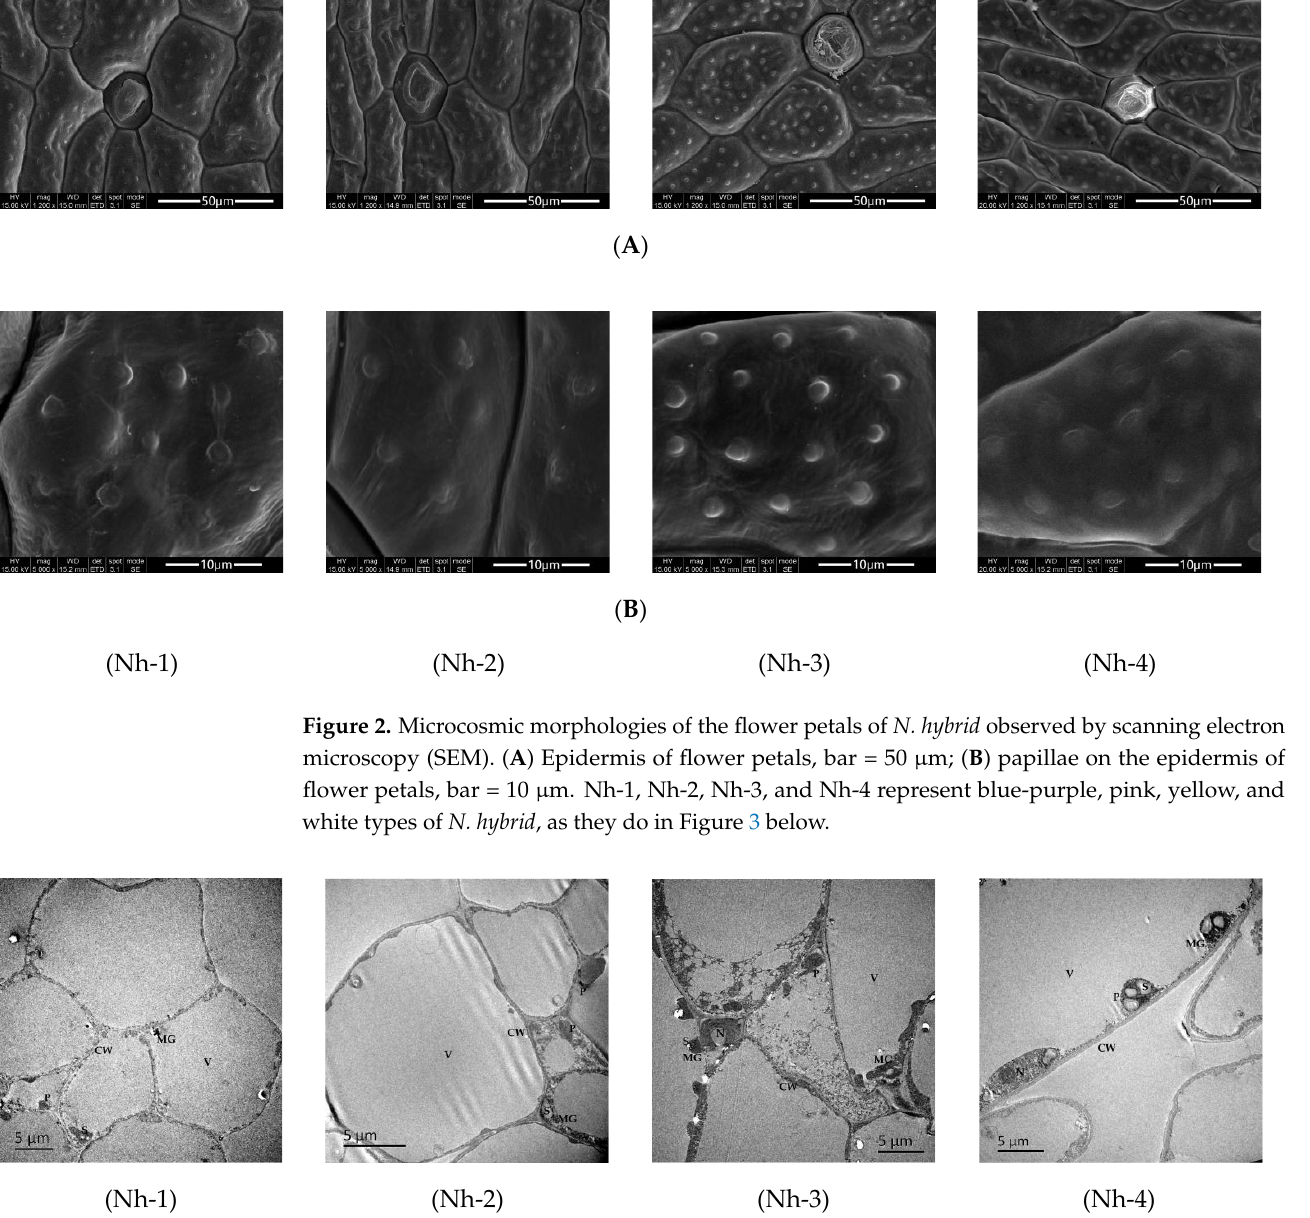
Figure 3. Microcosmic morphologies of the flower petals of N. hybrid observed by transmission electron microscopy (TEM), bar = 5 µ m.